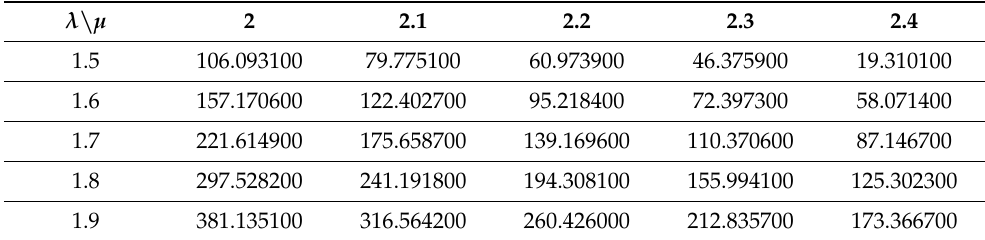
Table 3. Effect of λ vs. µ on the waiting time of a customer in the orbit ( Λ 4 ) . λ \